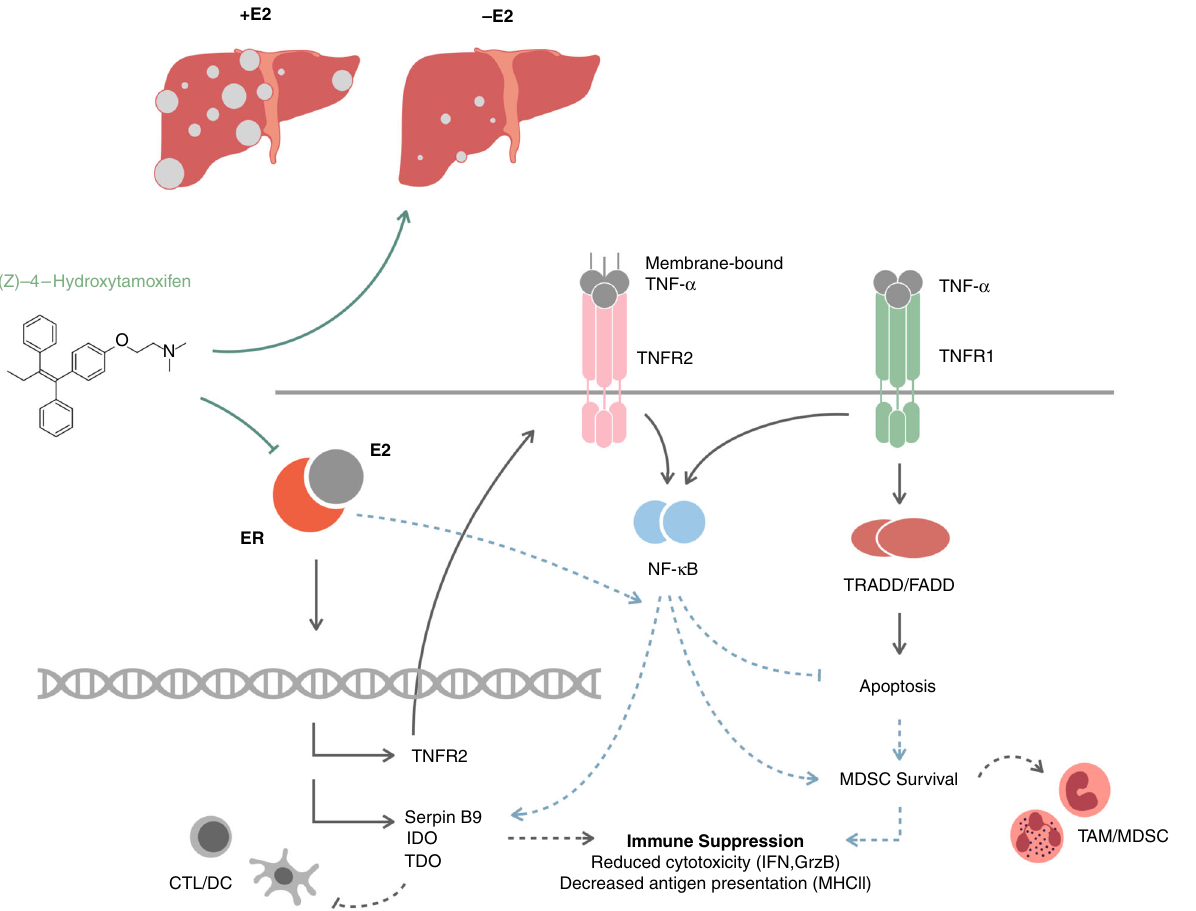
Fig. 10 The multifaceted role of estrogen in regulating an immunosuppressive TIME in the liver. Shown is a diagrammatic representation of postulated mechanisms that may be underlying the observed estrogen-mediated regulation of an immunosuppressive TIME in the liver. The ER/E2 signaling pathway can promote metastatic expansion in the liver by inducing TNFR2 transcription. In turn, TNFR2 may rescue immune cells from TNFR1-mediated death signals triggered by the TNF- α -rich microenvironment of LM and/or initiate signal transduction, leading to transcriptional activation of immunosuppressive gene products. This favors MDSC survival and suppressive activity, and reduces CD8 + T-cell-mediated antitumor responses. ER signaling (possibly in conjunction with, or independently of TNFR2) also regulates transcription of immunosuppressive proteins in the liver to enhance immune evasion. Tamoxifen treatment blocks the ER/E2 axis and reduces immune tolerance to improve tumor cell clearance (dashed lines indicate postulated molecular